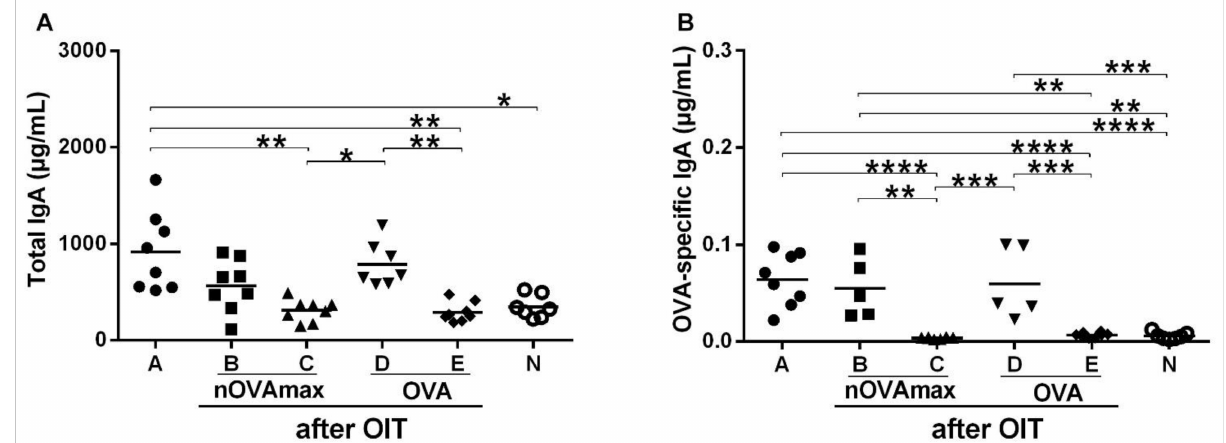
Figure 3. Measurement of OVA-specific IgA titers in the intestinal lavages after OIT. Intestinal lavages were collected and evaluated for ( A ) total and ( B ) OVA-specific IgA by ELISA. All the results for the total IgA were compared using the Kruskal–Wallis non-parametric test and Dunn’s multiple correction test, and the OVA-specific IgA results were analyzed with ANOVA combined with Tukey’s post-hoc test (* p < 0.05, ** p < 0.01, *** p < 0.001, **** p < 0.0001). Abbreviations used: